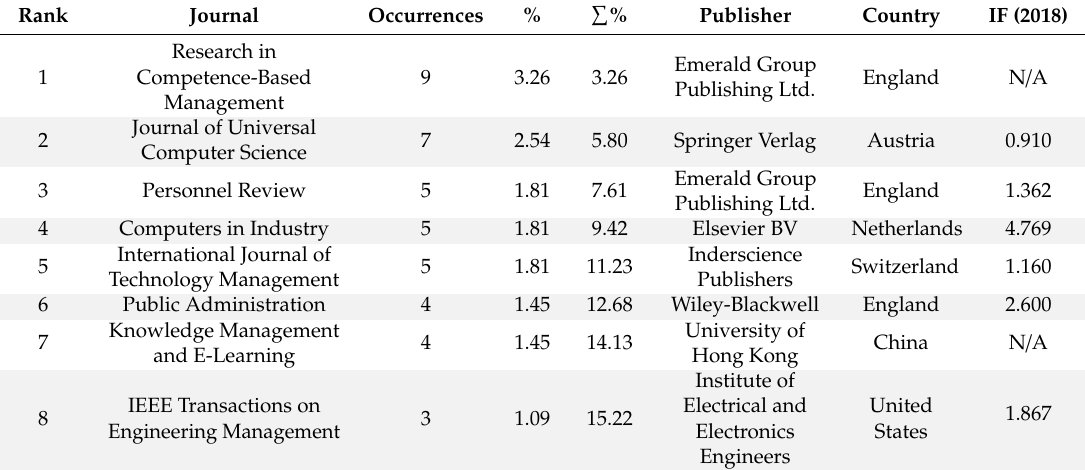
Table 5. Journals with the highest number of publications related to competence-based management.